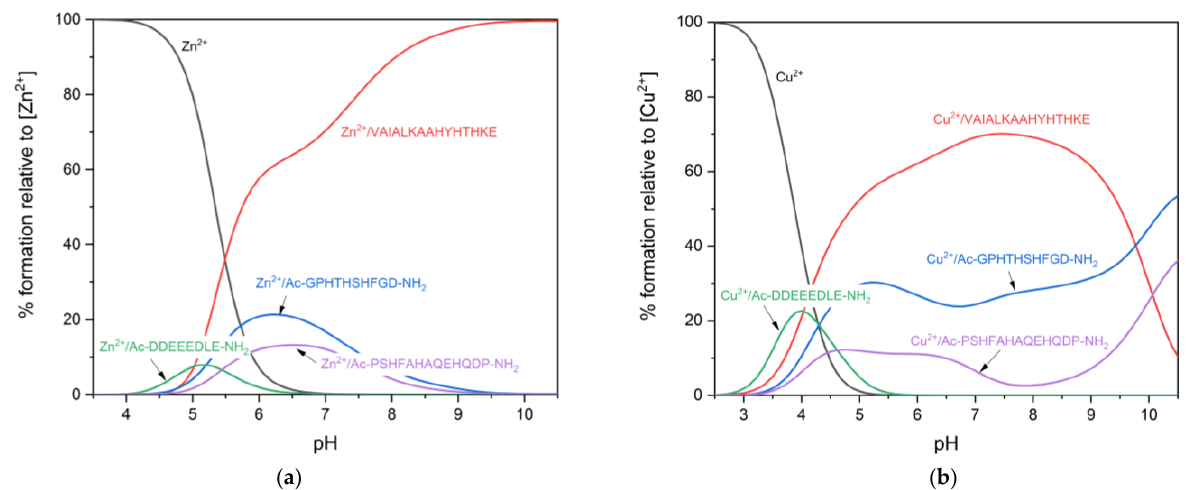
Figure 6. Competition plots for a solution containing equimolar concentrations (1 × ∙10 − 3 M) of VAIALKAAHYHTHKE (calcitermin), L1, L2, L3 (fragments from Zrt2) and ( a ) Zn 2+ ; ( b ) Cu 2+ .